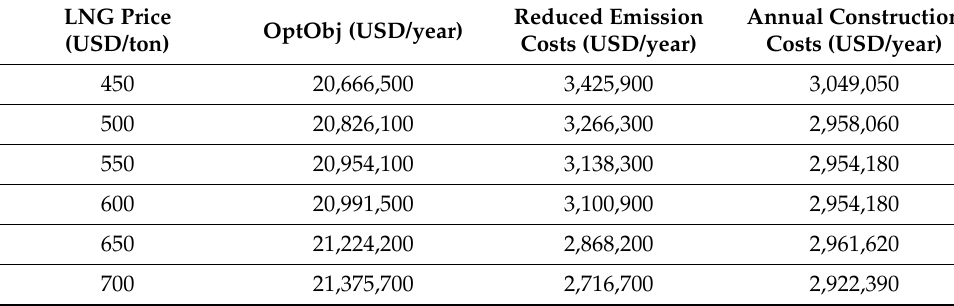
Table 3. Results of sensitive analysis on LNG bunkering